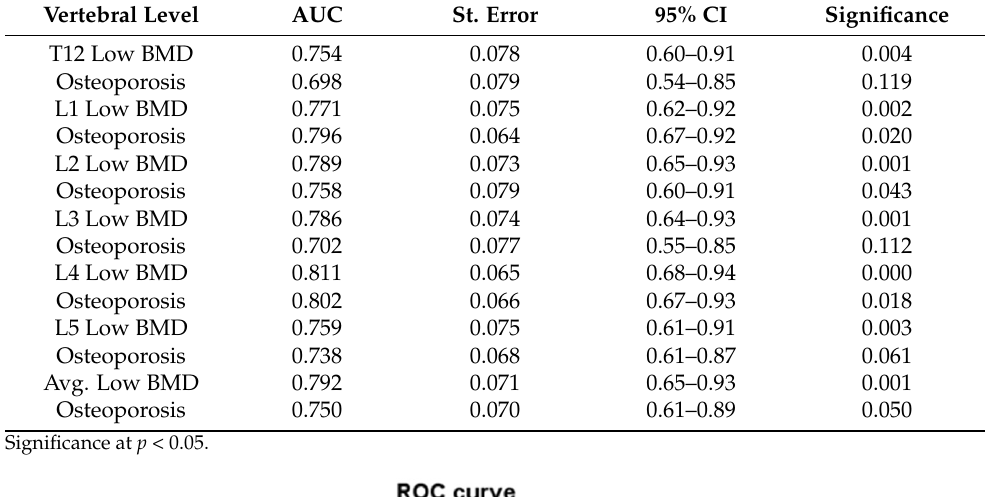
Table 3. Areas under the curve for diagnosis of low and osteoporotic bone mineral density by CT attenuation at each vertebral level.